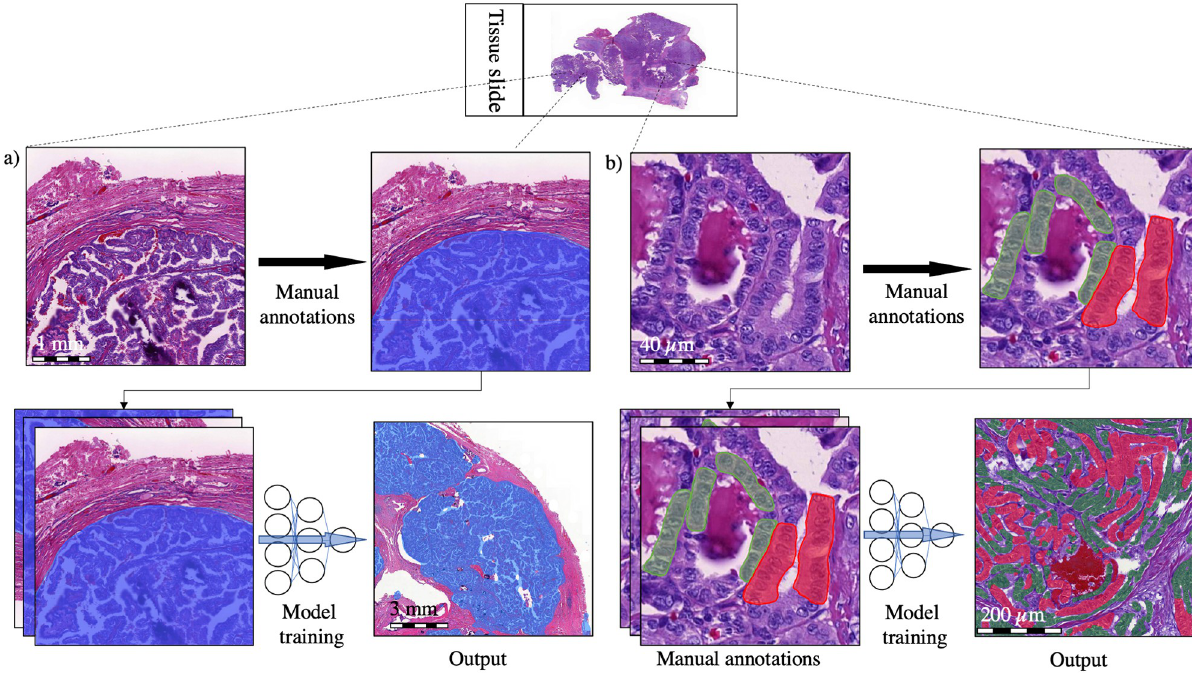
Fig 2. The convolutional neural network model consisted of two algorithms. a) A segmentation algorithm detects the tumor tissue (blue), which is fed as an input to a b) tall cell (TC) segmentation algorithm trained to detect TC epithelial regions (red) as well as non-TC epithelial regions (green). Finally, the TC score of the total epithelial area was calculated.